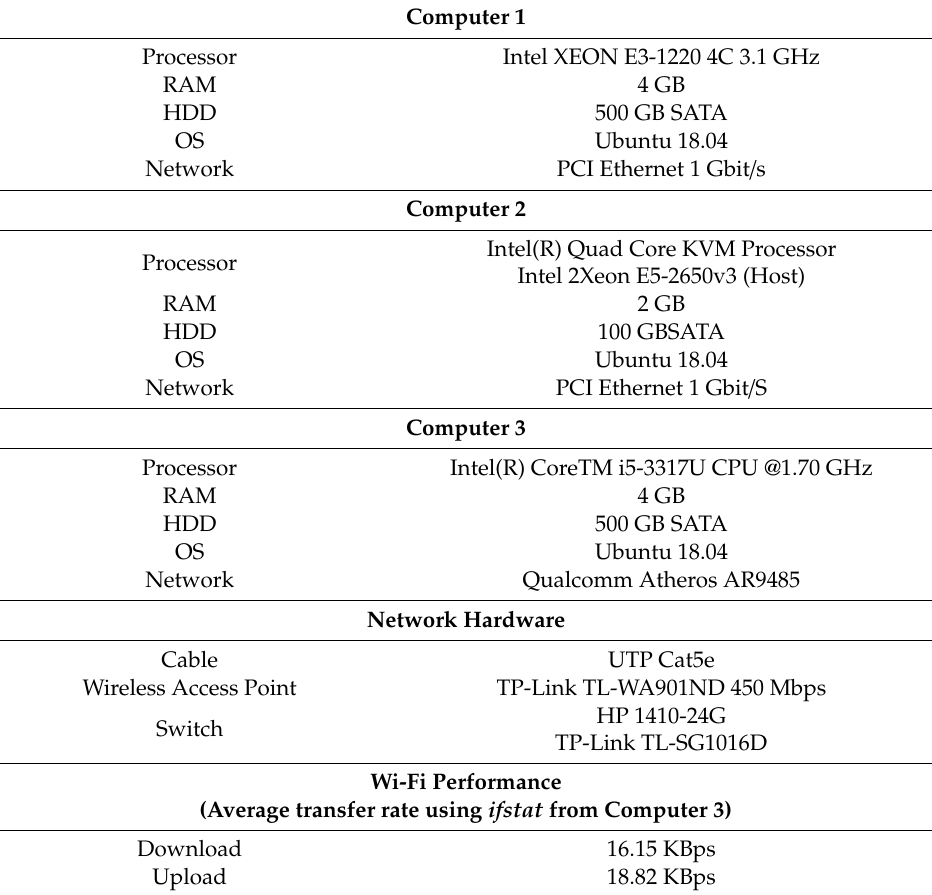
Table 2. Specifications of tested